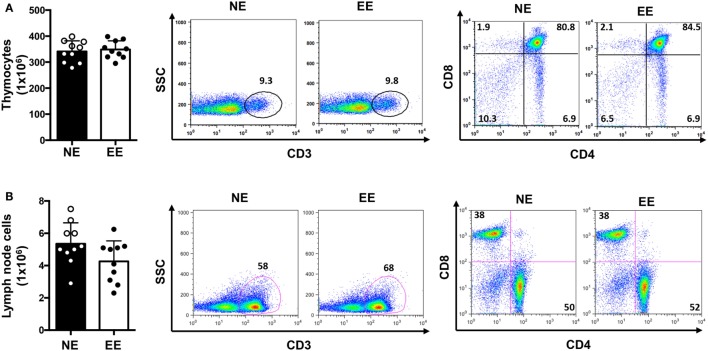
T cell immune repertoire of C57/Bl6 mice after 2 weeks of EE. The bar graphs on the left side show the absolute numbers of thymocytes (A) and lymph node (B) cells in NE and EE mice. The dot plots show the percentage of CD3+ T cells (middle panels) or the percentages of CD4+ and CD8+ T cells (right panels) collected from thymus (top panels) or lymph nodes (bottom panels) of NE and EE mice. The numbers in the plots show the percentages of gated populations. Data shown are from a single mouse and representative of n = 4 separate experiments with five mice per each group.